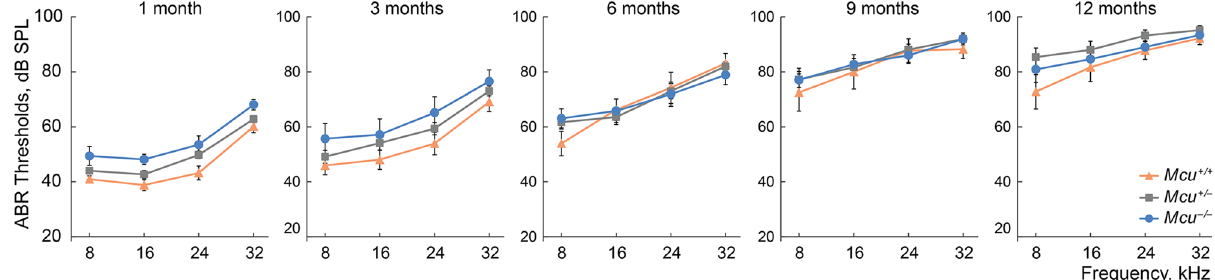
Figure 1. Mice on the mixed B6-CD1 background are predisposed to rapidly progressing hearing loss at all frequencies. Auditory brainstem responses (ABRs) were recorded from the Mcu + / + , Mcu + /− , and Mcu −/− mice on the mixed B6-CD1 background at various time points. Mcu −/− mice show a trend toward slightly elevated ABR thresholds up to three months of age. Although analyses did not show any statistically significant differences among Mcu + / + , Mcu + /− and Mcu −/− mice, as assessed using two way ANOVA followed by Bonferroni multiple comparison test. Not every mouse was tested at each time point. Number of mice ( Mcu + / + , Mcu + /− , Mcu −/− ): 1 month (23, 32, 11); 3 months (17, 30, 12); 6 months (12, 28, 19); 9 months (10, 25, 19); 12 months (9, 33,